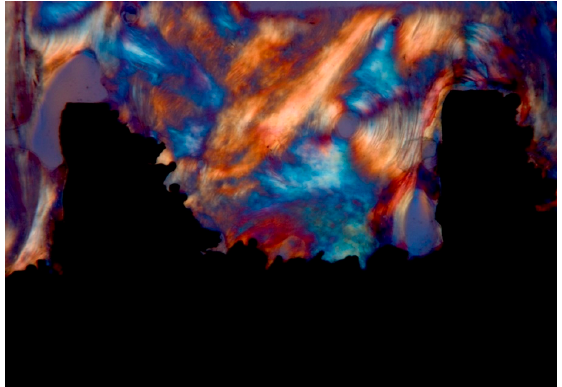
Figure 3. Transverse collagen fibers near an implant thread, under Compensated polarized light (CPL) microscopy: An osteon was present inside a thread. Implant retrieved for fracture after 8 years loading period: Single implant. Courtesy of Dr. Carlo Mangano. (toluidine blue and acid fuchsin staining, magnification 40 ×